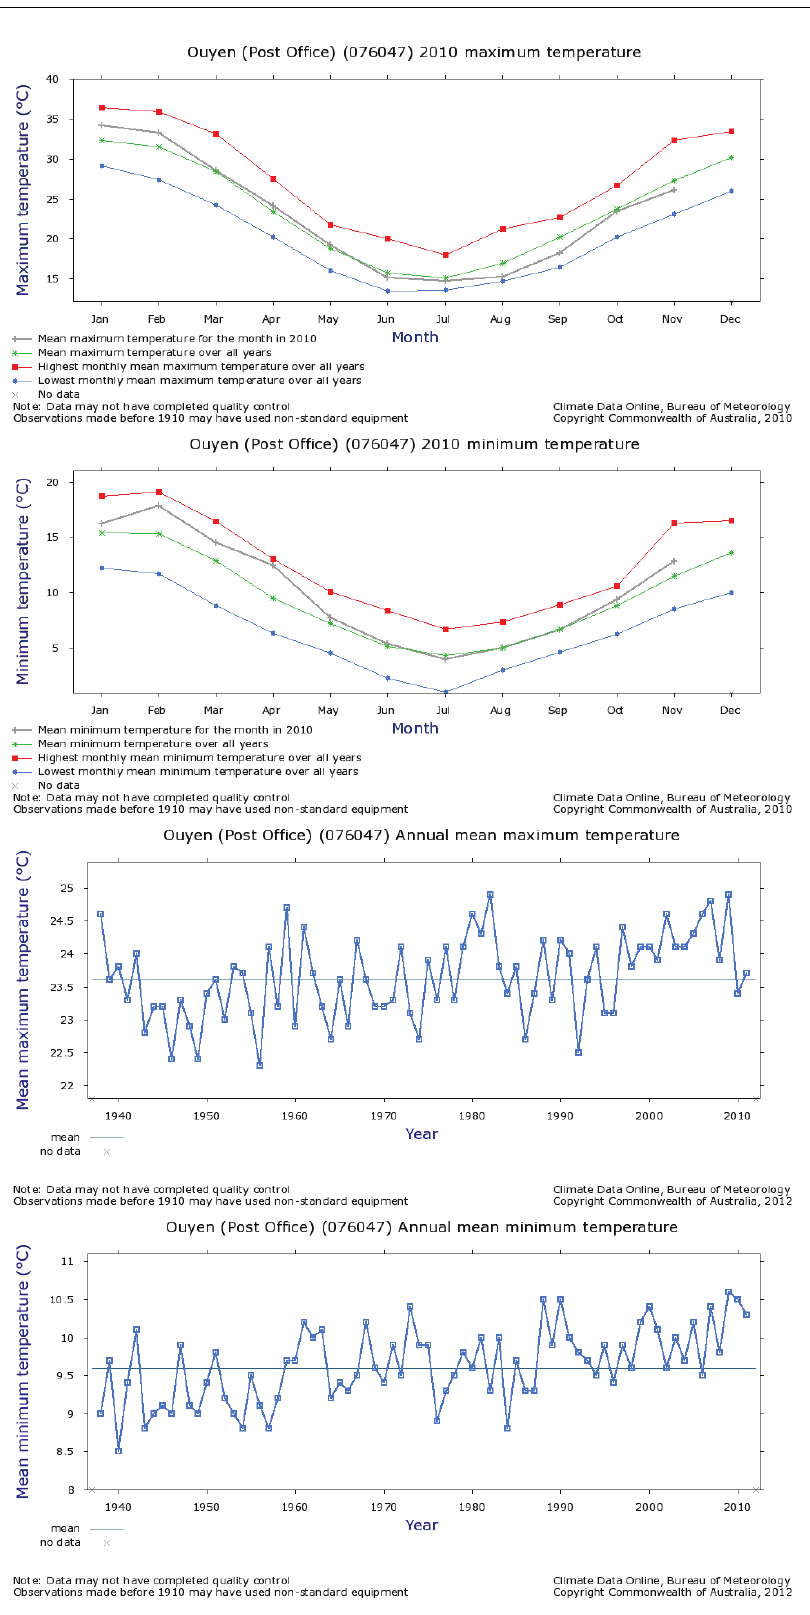
Figure 18. Australian Government Bureau of Meteorology temperature graphs for historical locations in Victoria, Aus-